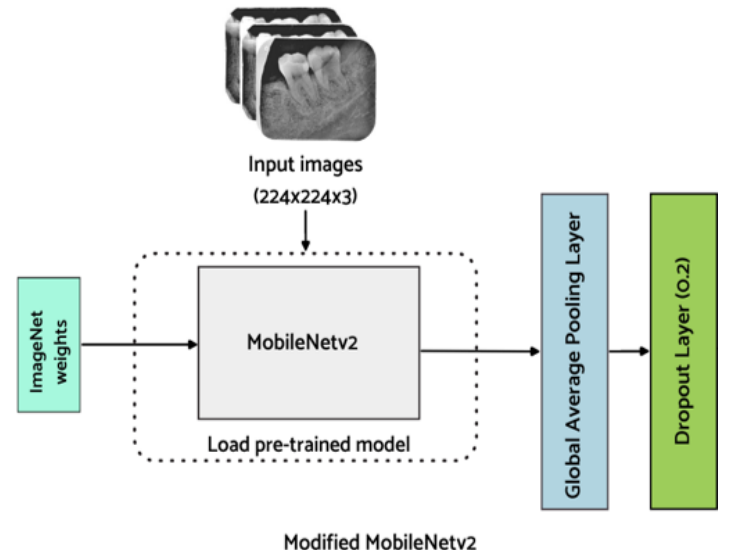
Figure 5. Proposed backbone network (Modified